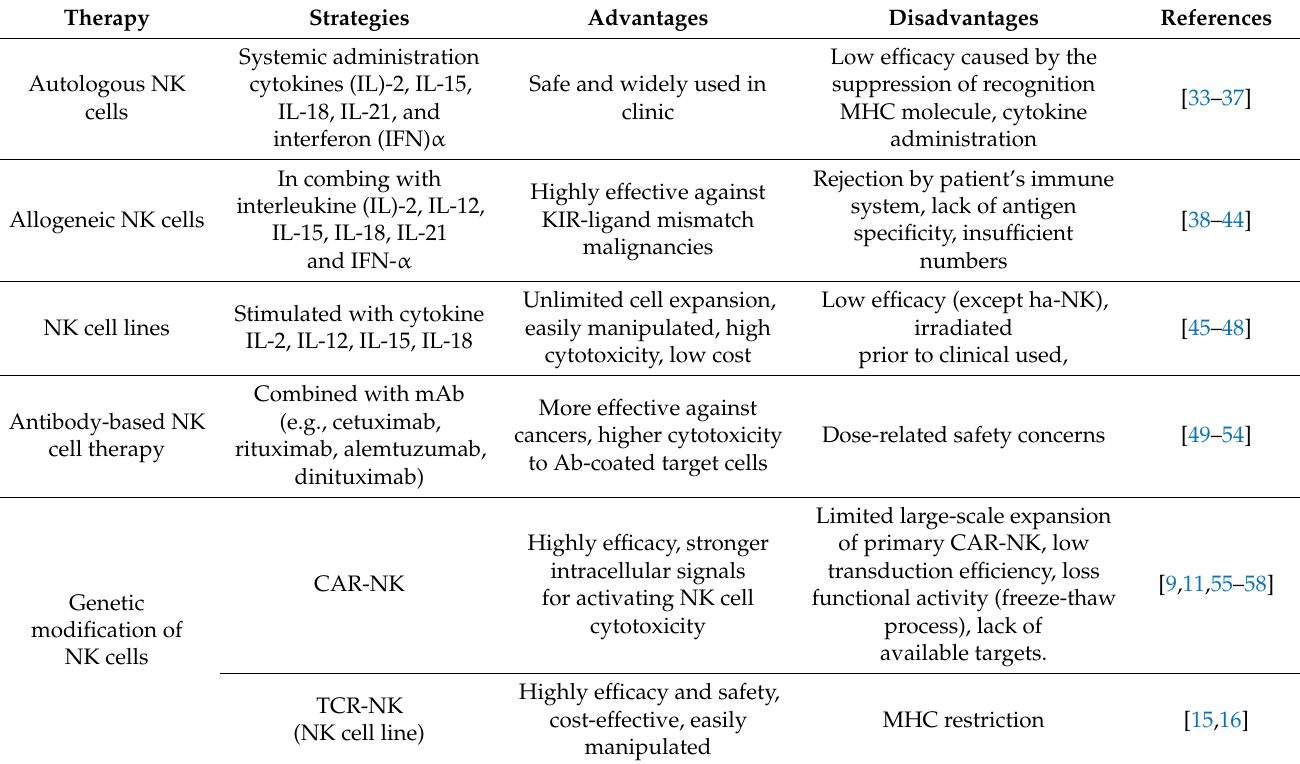
Table 1. Strategies to eliminate tumors and some